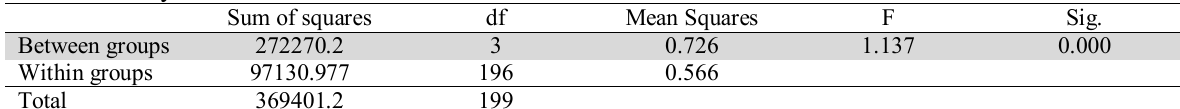
The summary of ANOVA test Sum of squares df Mean Squares F Sig. Between groups 272270.2 3 0.726 1.137 0.000 Within groups 97130.977 196 0.566 Total 369401.2 199